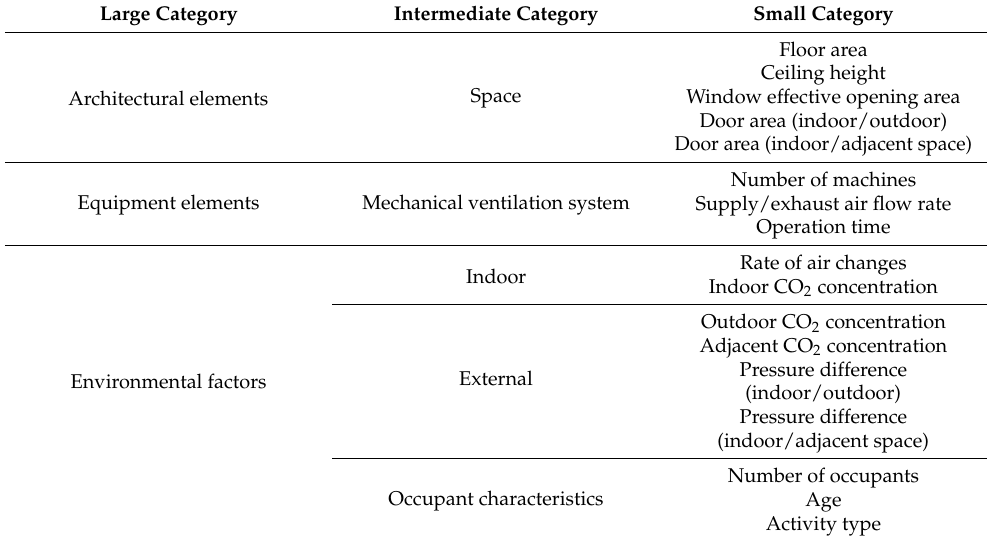
Table 5. Category selection according to the classification of factors affecting changes in CO 2 concen- tration.